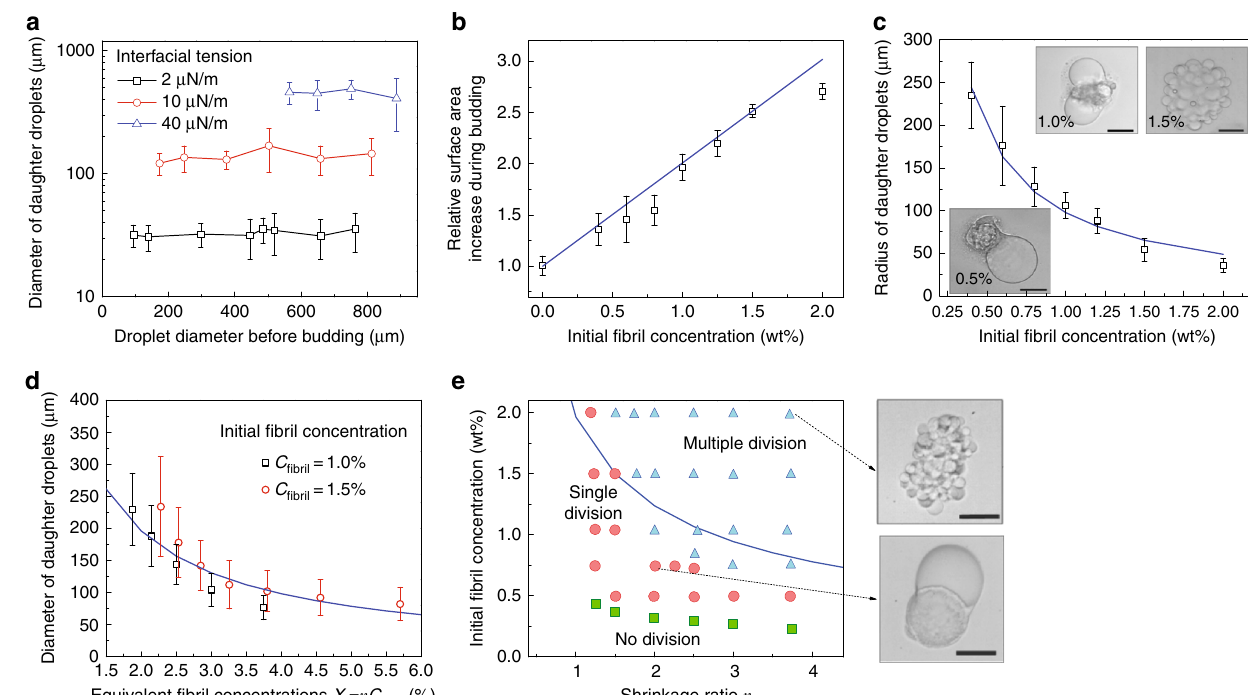
Fig. 3 Fibril networks control the number and size of daughter droplets. a The average diameter of daughter droplets is independent of the size of the mother droplet but increases linearly with increasing w/w interfacial tension. b After decomposition of fi bril networks, the total surface area of the daughter droplets increases linearly with initial fi bril concentration. c Radius and number of stabilized protrusions as a function of fi bril concentration. Scale bars, 100 µ m. d Diameter of stabilized daughter droplets as a function of the product of shrinkage ratio ( η ) and initial fi bril concentration ( C fi bril ). e Phase diagram summarizing the effects of shrinkage ratio and initial fi bril concentration on the division regimes of w/w droplets loaded with protein nano fi brils. The initial diameter of the mother droplet was 250 ±20 µ m. Inset: optical microscope images showing representative w/w droplets in the multiple (top) and single (bottom) division regimes. Scale bars are 200 µ m. The solid blue lines in a – e are predictions from Eq. (2). The size of daughter droplets, measured from 50 replicates, are expressed as (mean ±s.d.)